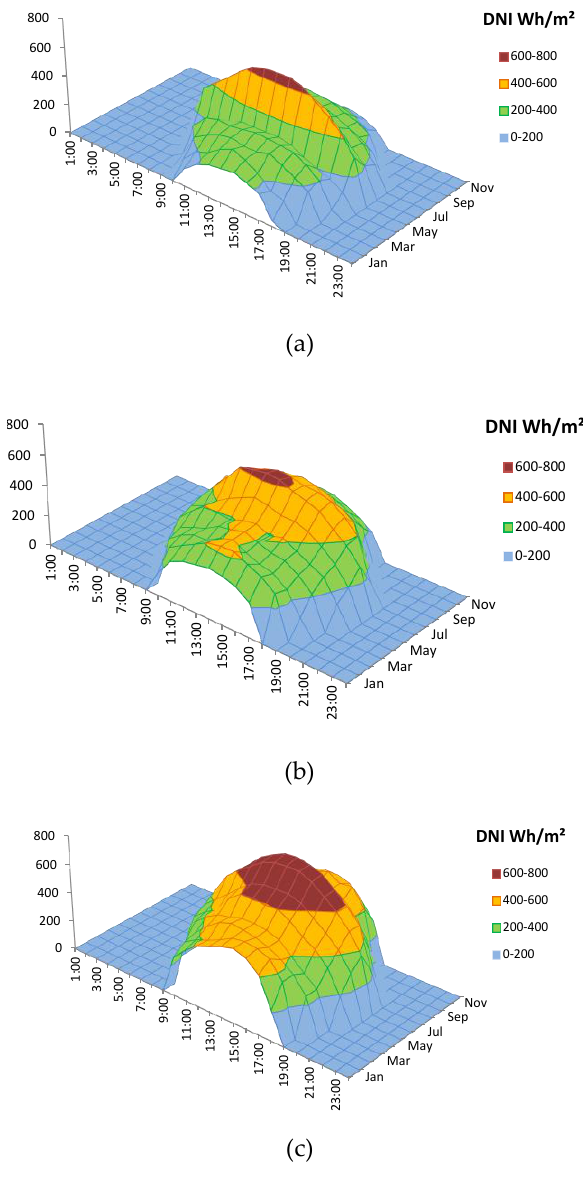
Figure 2. Average curves from yearly DNI. ( a ) Vittoria (Italy); ( b ) Posadas (Spain); ( c ) Death Valley, CA (USA).